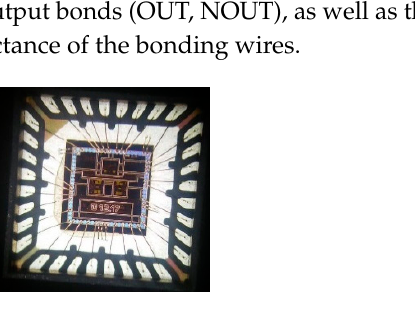
Figure 17. Prototype of the chip carrying the proposed LCR driver circuit in QFN32 package.